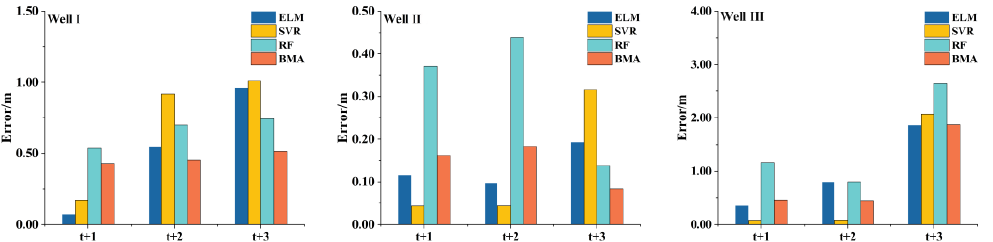
Figure 4 . The errors of the lowest GWL predictions for the ELM, SVR, RF, and BMA models for Wells I, II, and III at 1-, 2-, and 3-month-ahead prediction horizons in the testing period.